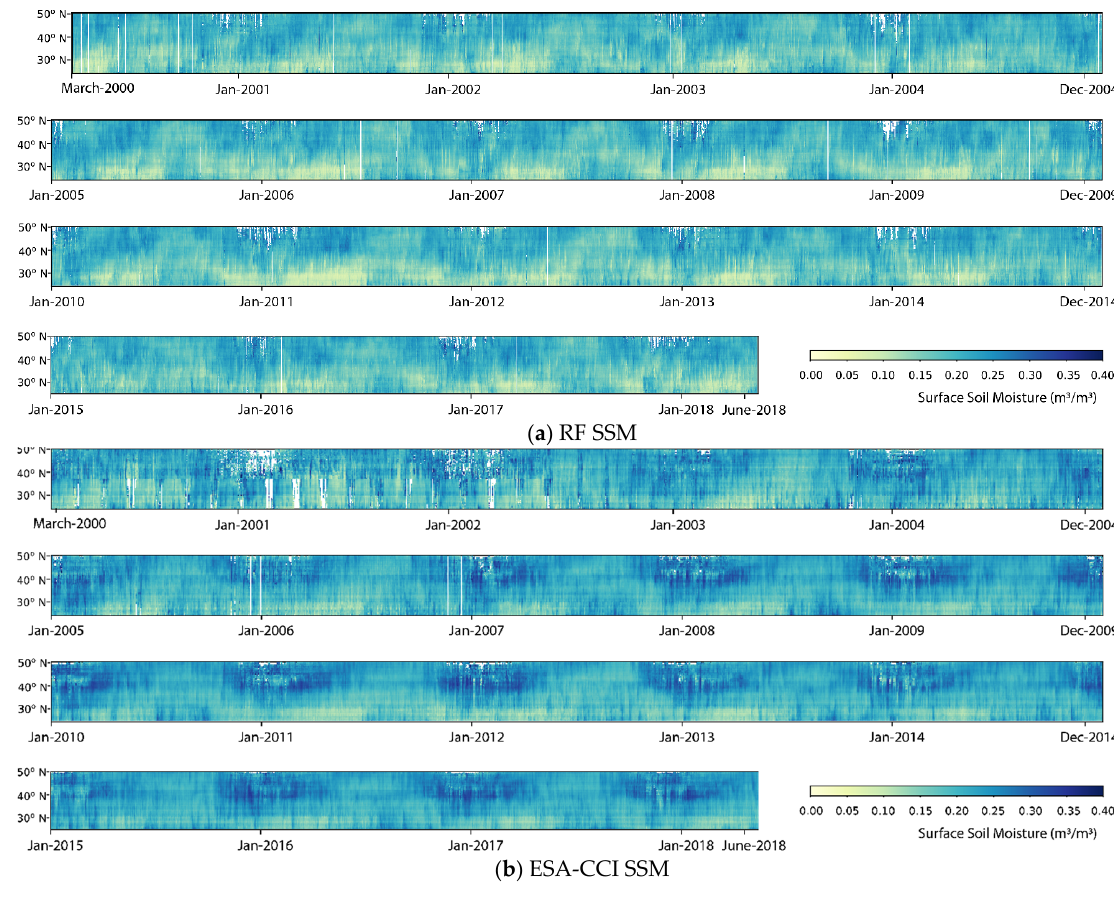
Figure 10. Time-latitude diagram over the continental U.S.